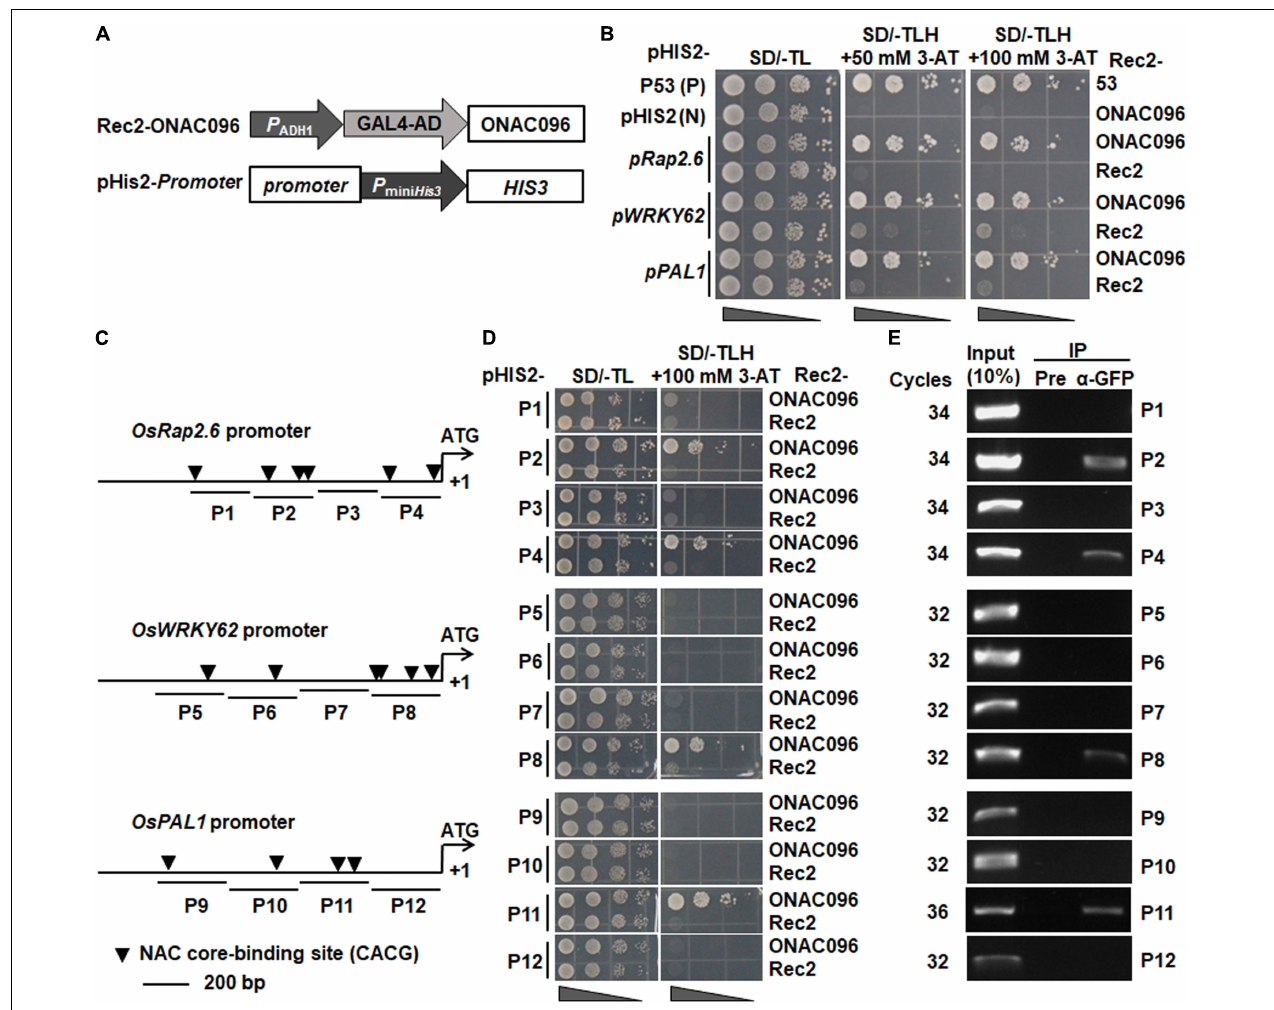
FIGURE 7 | ONAC096 directly regulates the expression of OsRap2.6 , OsWRKY62 , and OsPAL1 . (A) Schematic diagram of plasmids Rec2-ONAC096 and pHis2- promoter used in Y1H assay. (B) ONAC096 binds to the promoters of OsRap2.6 , OsWRKY62 , and OsPAL1 in yeast cells. DNA-protein interactions were verified by growth performance of yeast cells co-transformed with indicated pairs of Rec2 and pHis2 vectors on SD/-Leu-/Trp/-His medium containing 50 mM or 100 mM 3-AT. (C) Diagram of putative NAC core-binding sites in the promoters of OsRap2.6 , OsWRKY62 , and OsPAL1 . P1-P12 were the primers used in Y1H assays and probes used in ChIP-PCR assays. (D) Y1H assays of ONAC096 binding to the promoters of OsRap2.6 , OsWRKY62 , and OsPAL1 . The partial truncated sequences of the promoters of OsRap2.6 , OsWRKY62 , and OsPAL1 were fused into reporter vector pHis2, respectively. Transformants harboring each of the different truncated constructs with Rec2-ONAC096 or Rec2 empty vector (a negative control) were dropped by a series of 10-fold dilutions on plates of SD/-Trp-Leu, and SD/-Trp-Leu-His/100 mM 3-AT. (E) ChIP-PCR analysis of ONAC096 binding to the promoters of OsRap2.6 , OsWRKY62 and OsPAL1 . ChIP of fragmented DNA isolated from ONAC096 -GFP transgenic line incubated with GFP antibody ( α -GFP) or pre-immune (Pre) serum (a negative control) and PCR analysis of IP samples and chromatin DNA before IP (a positive control/input) were performed using the P1-P12 primers. Experiments were repeated for three times with similar results, and results from one representative experiment are shown in panels (B,D,E)